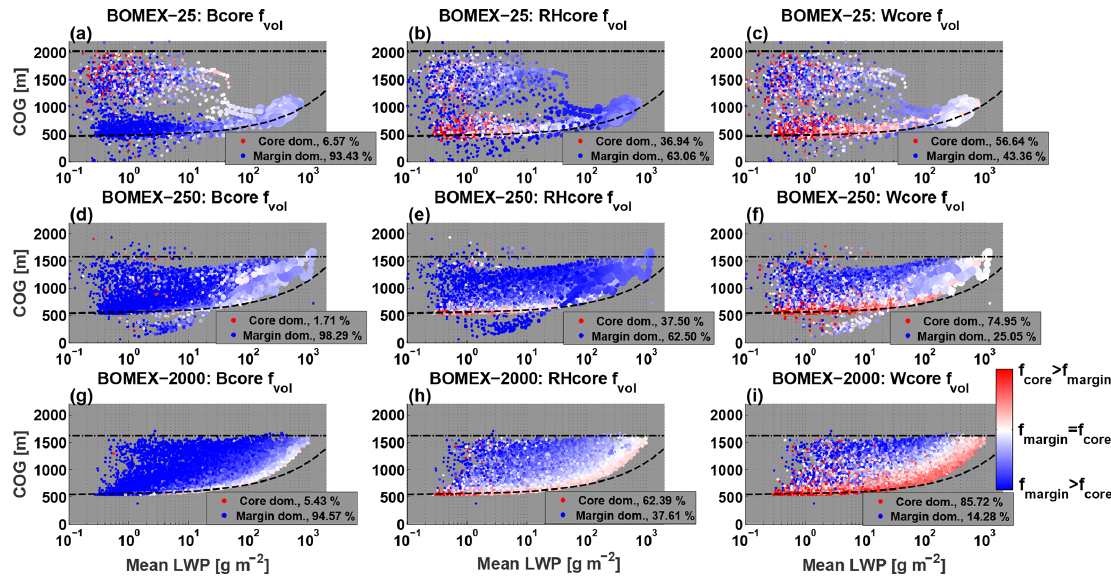
Figure 5. CvM phase-space diagrams of B core (a, d, g) , RH core (b, e, h) , and W core (c, f, i) volume fractions ( f vol ) for all clouds between 3 and 8h in the BOMEX simulations. The rows correspond to the clean (a, b, c) , intermediate (d, e, f) , and polluted (g, h, i) aerosol cases. The red (blue) colors indicate a core f vol above (below) 0.5. The size of each point in the scatter is proportional to the cloud mean area, where the smallest (largest) point corresponds to an area of 0.01km 2 (11.4km 2 ). The percentage of clouds that are core dominated (f vol > 0 . 5 ) is included in panel legends. For an in-depth description of CvM space characteristics, the reader is referred to Sect. 2.4 in